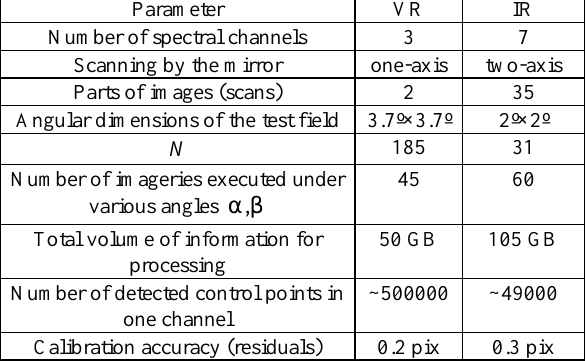
Table 1. Modes and results of MSU-GS calibration